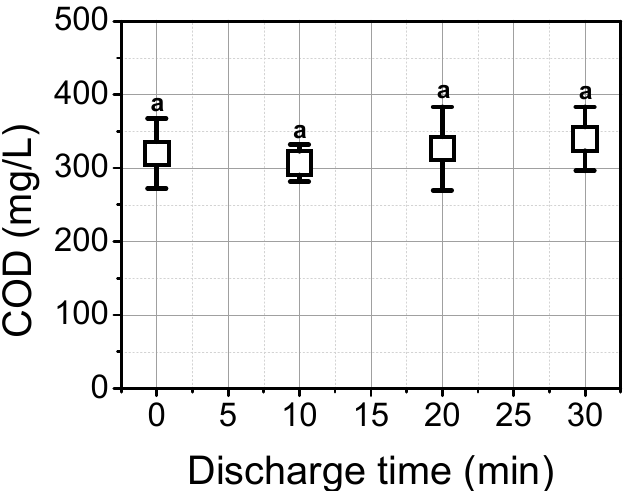
Figure 5. The effect of underwater plasma treatment on the chemical oxygen demand (COD) in waste brine. Different letters indicate significant differences ( p < 0.05).